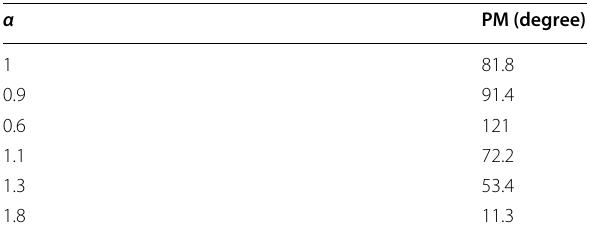
Table 8 GM and PM of the RSC control circuit using FFOADRC (for k 1.1, ω 10, k 1, and different α ) 2d = c = 1d =